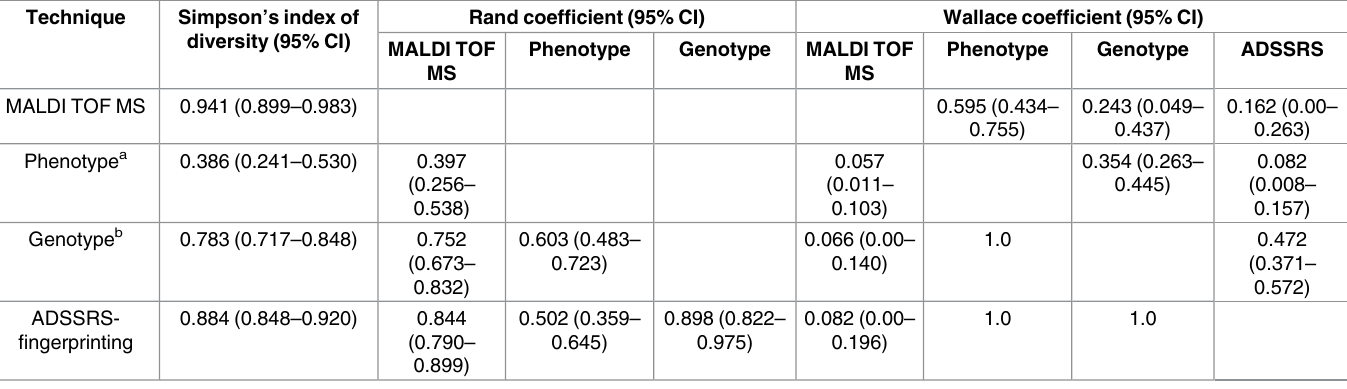
Table 2. Statistic comparison of the typing methods used in this study.